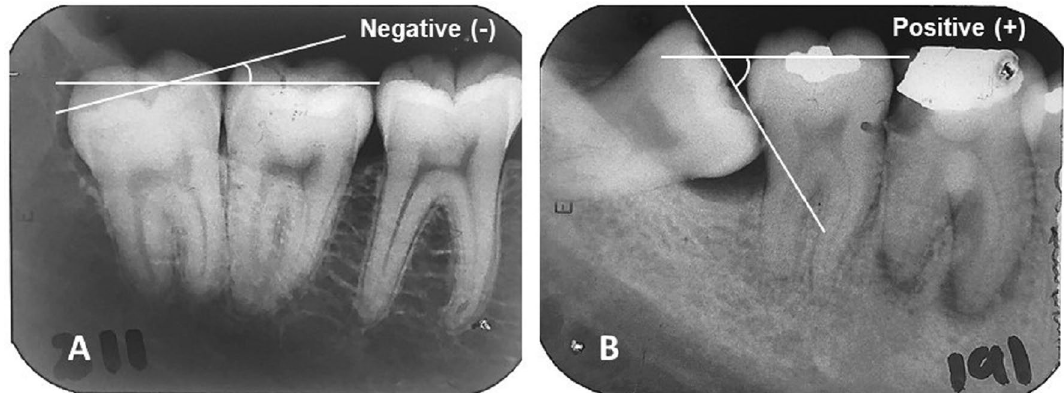
Figure 1. Angulation between lower 3 M and adjacent 2 M. A line drawn parallel to the 3 M occlusal plane, touching the tips of the cusps and traced along the mesiodistal axis of the tooth, was used as a reference. A similar line drawn parallel to the adjacent 2 M occlusal plane intersects the reference line and creates an angle. ( A ) The angle created below the reference line is classified as negative. ( B ) The angle created above the reference line is classified as